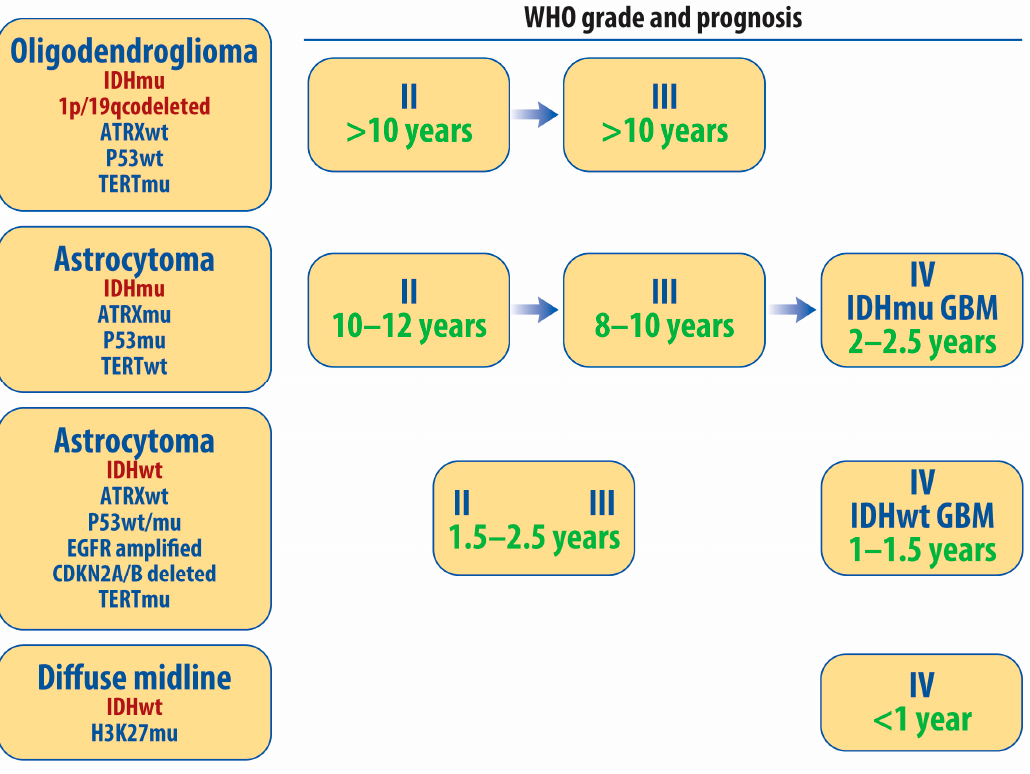
Figure 1. Classification of diffuse gliomas. As of 2016, diffuse gliomas are now defined based on both their molecular and histologic features. Definitional molecular features are noted in red, while other common molecular features are also listed. For most diffuse gliomas, the grade is still determined by the presence of conventionally defined “aggressive” microscopic features such as atypia, mitoses, microvascular proliferation, and necrosis. H3K27 mutant midline gliomas are grade 4 based on their molecular features. Median survival estimates for each type of molecularly defined tumor receiving optimal therapy are listed in green, though many of these estimates should be viewed as preliminary due to the recent reclassification of these tumors [4,33–42] .